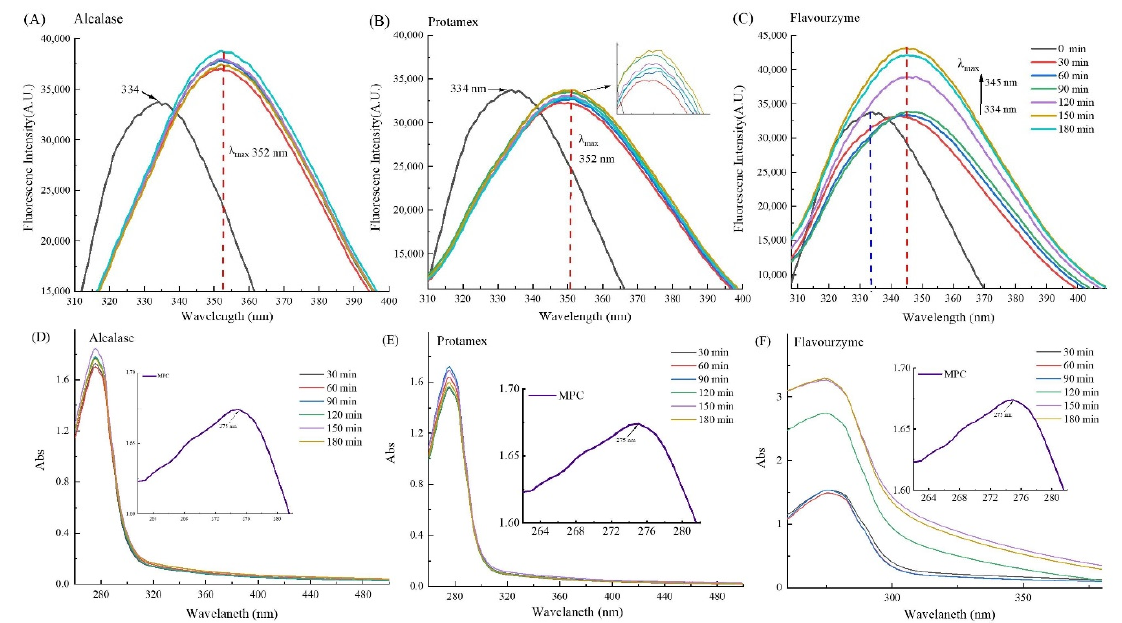
Figure 3. Structural characterization of MPC and hydrolysates. Relative fluorescence spectra of milk protein concentrate and hydrolysates prepared with Alcalase ( A ), Protamex ( B ), and Flavorzyme ( C ); as well as UV–visible spectra of MPC and hydrolysates prepared with Alcalase ( D ), Protamex ( E ), and Flavorzyme ( F ).